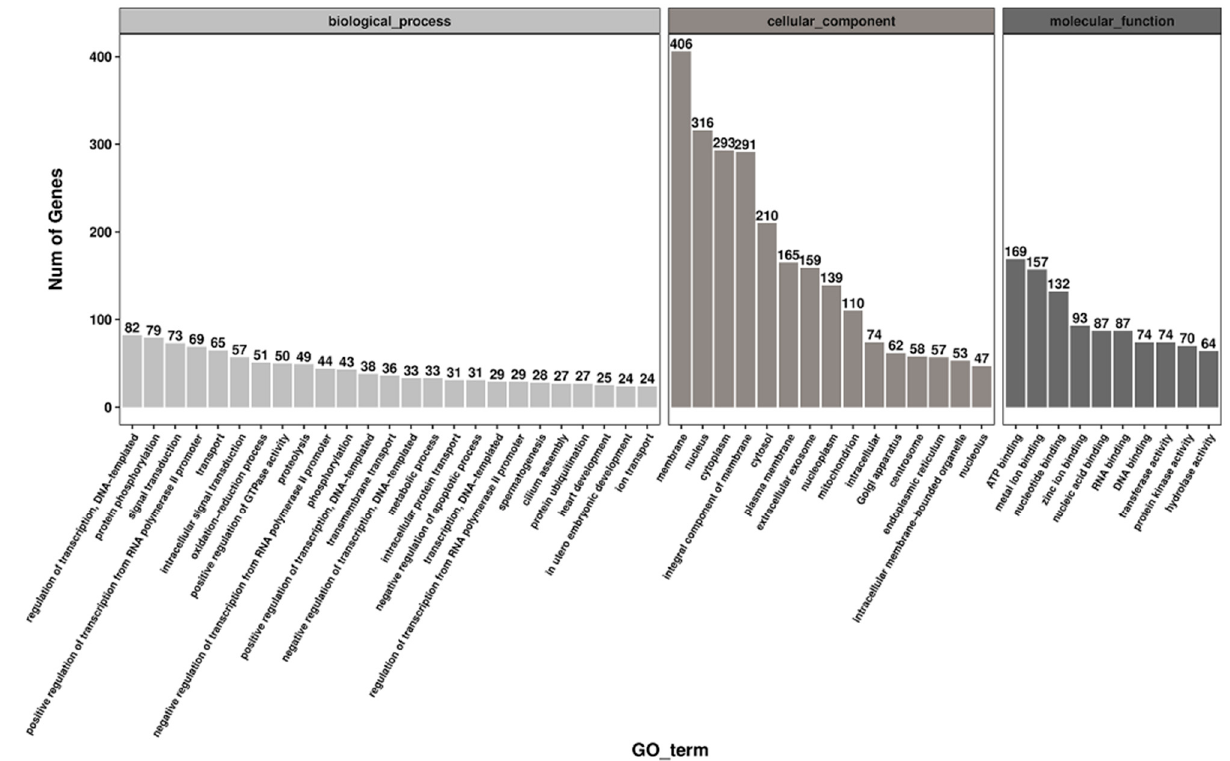
Figure 5. Gene ontology (GO) analysis of differentially expressed circRNA source genes. GO analysis of the top enriched terms of the differentially expressed circRNA hosting genes identified in young (Piglet-D30) and sexually mature (Adult- D210) boar testes. The source genes are divided into three ontologies by GO analysis (left: biological process, middle: cells, organ components, right: molecular